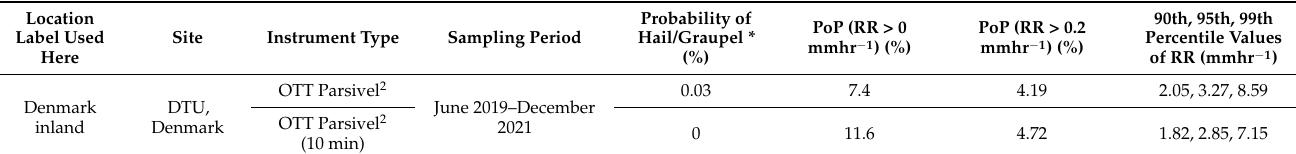
Table 2. Summary of precipitation statistics at the six primary long-term study sites for all available instruments. PoP denotes probability of precipitation and is computed using two different rainfall rate (RR) thresholds. * The values for the three disdrometers at US SGP reflect all 1 min periods when all three instruments reported valid data. Probability of hail/graupel is defined using hail as Weather Codes (WC) 87, 88, 89, 90, except for Bergen where the OTT Parsivel 2 indicates a very high prevalence of WC 87 or WC 88 (2.8% of all observations have one of these two codes). Unless other- wise stated the sampling intervals over which the data are averaged is 1-min. See DSD for these sites in Figures 5 – 9. Location Label Site Used Here